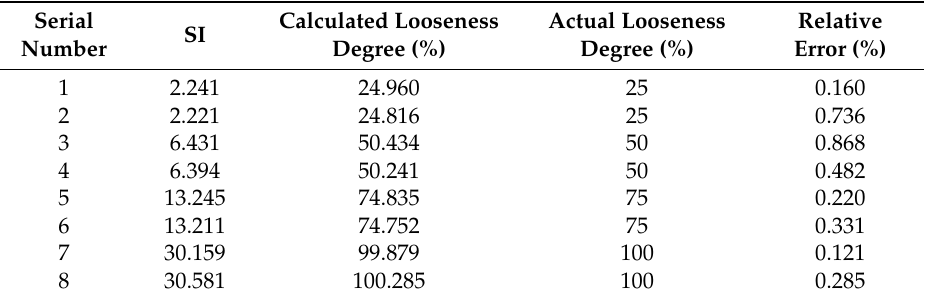
Table 5. The test results of sensor #1 under different